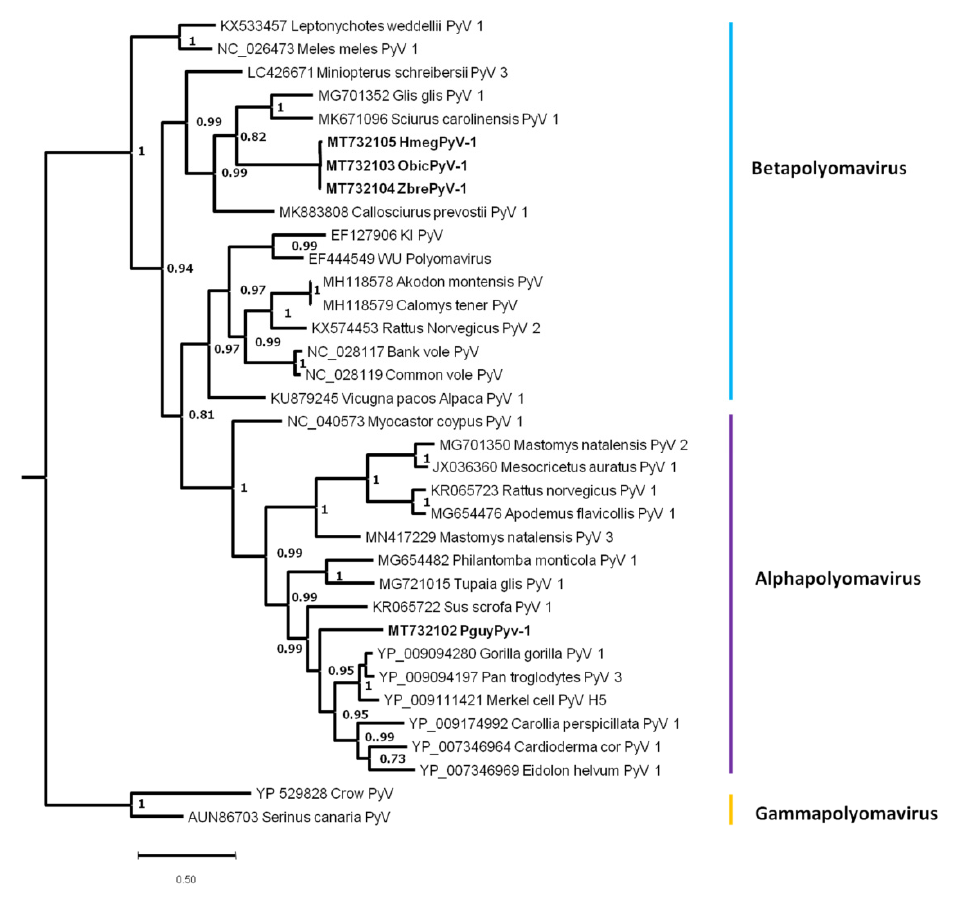
Figure 5. Phylogenetic analysis of partial sequences of the Large T antigen (LTAg) (alignment of 166 amino acid positions) of Polyomaviridae representatives (Alpha, Beta, and Gammapolyomaviruses with Gammapolyomaviruses as the outgroup). The tree was inferred from amino acid sequences using the Bayesian method with the WAG model. Sequence identifiers include the NCBI accession number and the isolate name. Posterior probabilities of the Bayesian analysis (>70%) are shown next to the nodes. The scale bar indicates amino acid substitutions per site. Sequences identified in this study are shown in bold.